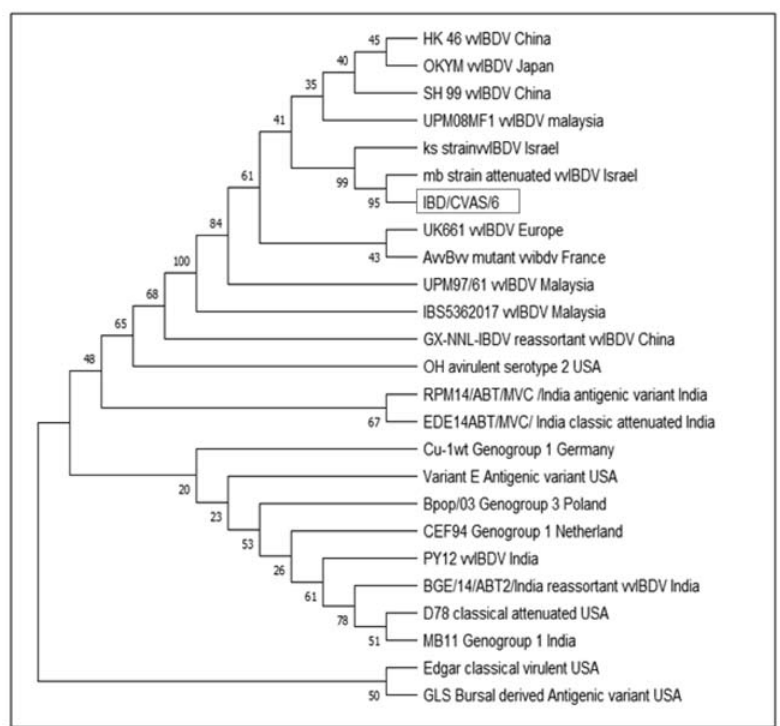
Fig.4. Phylogenetic tree based on the analysis of 2640bp nucleotides of VP1